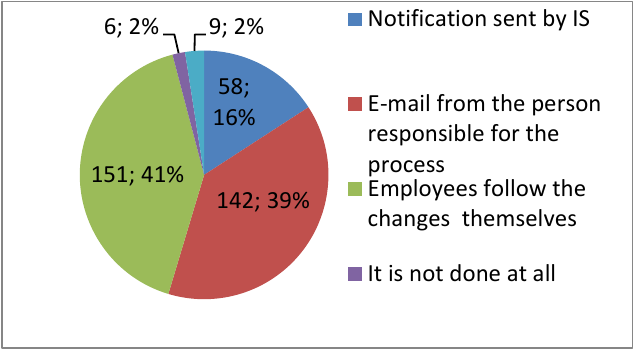
Fig. 5. Receiving information about changes in